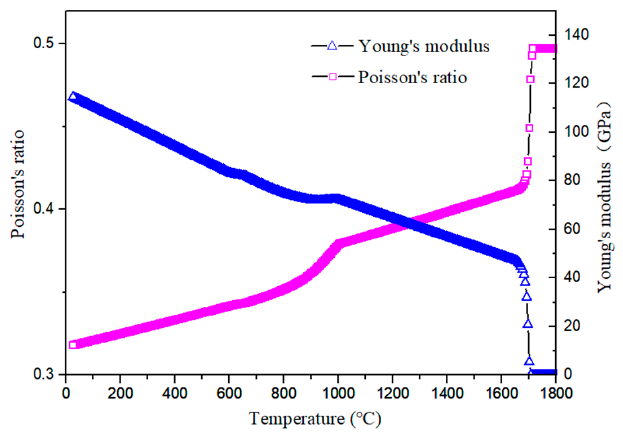
Figure 14. Variation of Young’s modulus and Poisson’s ratio with temperature.